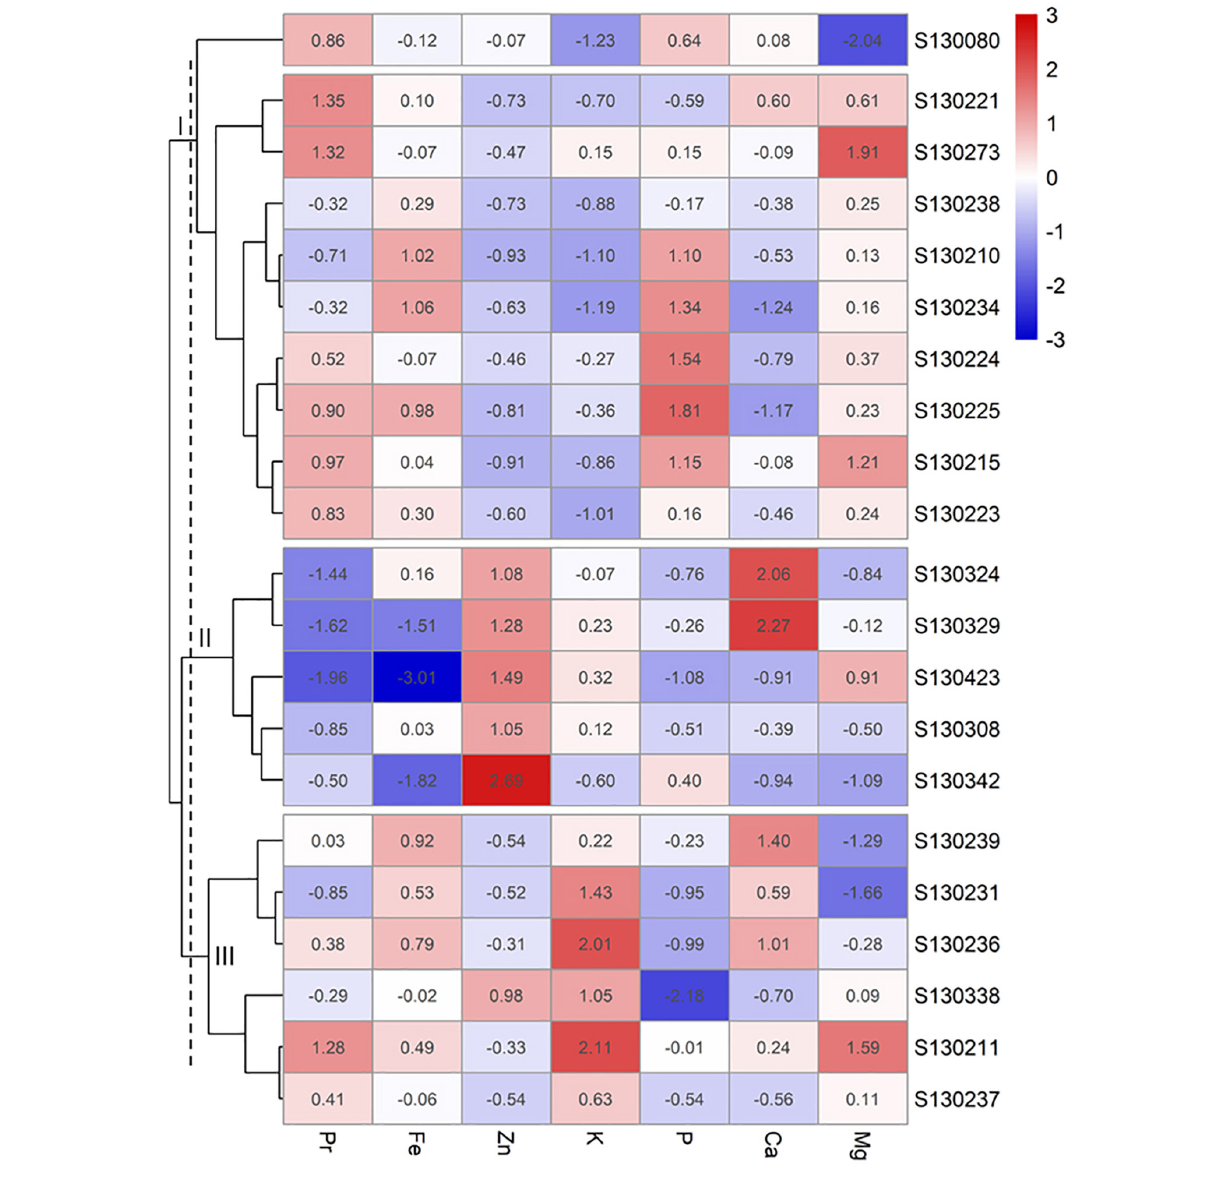
FIGURE 6 | Heatmap and hierarchical clustering of 21 genotypes selected based on protein and major micronutrients (Fe and Zn) and macroelements (K, P, Ca, and